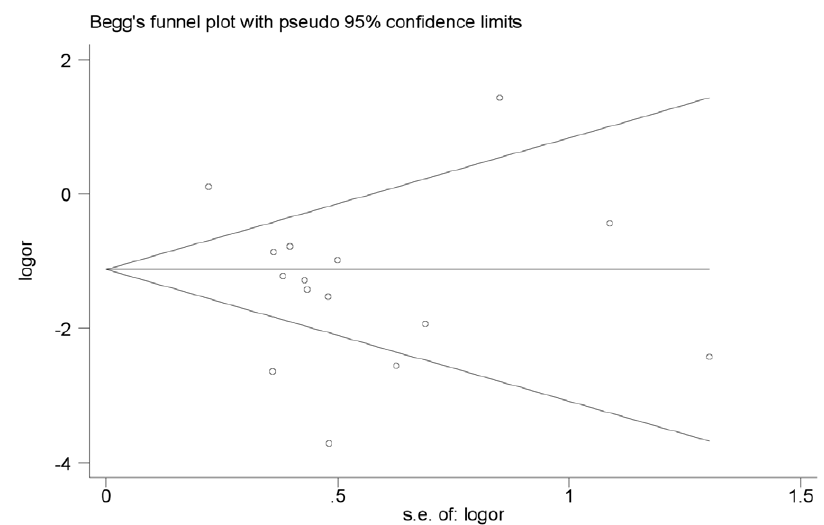
Figure 4. Begg’s test result of 5-year OS rate. doi:10.1371/journal.pone.0056380.g004 PLOS ONE |